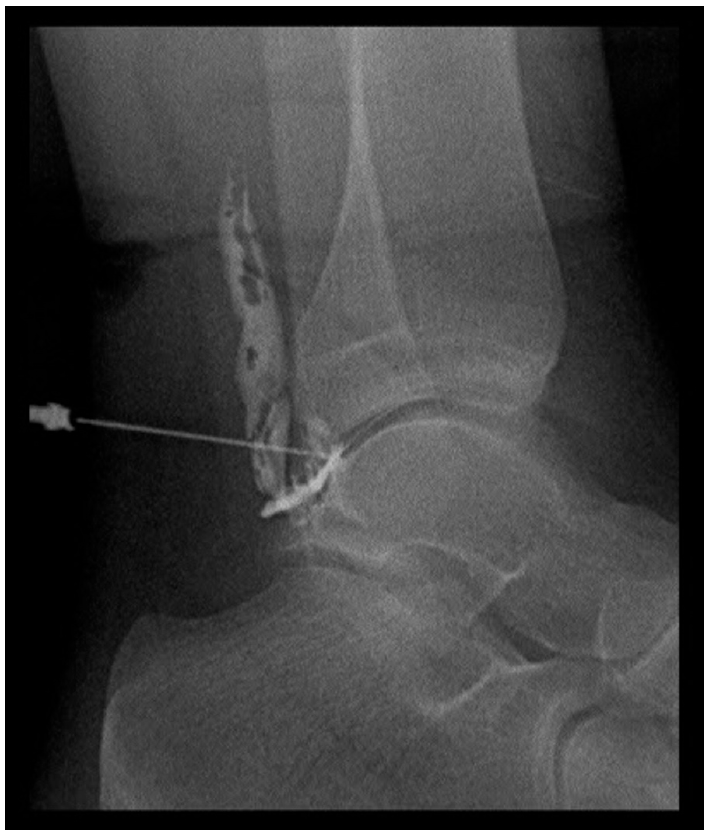
Figure 3. X-ray of the ankle joint confirming correct needle position before application of erbium-169 ( 169 Er).